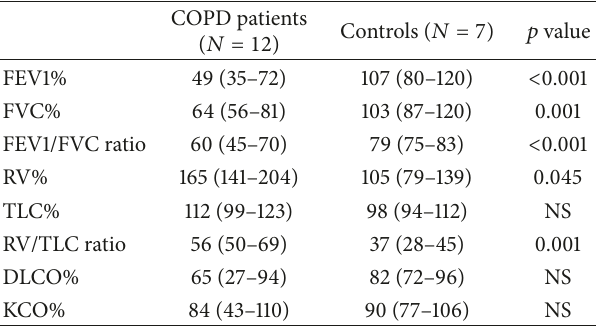
Table 3: Lung function test